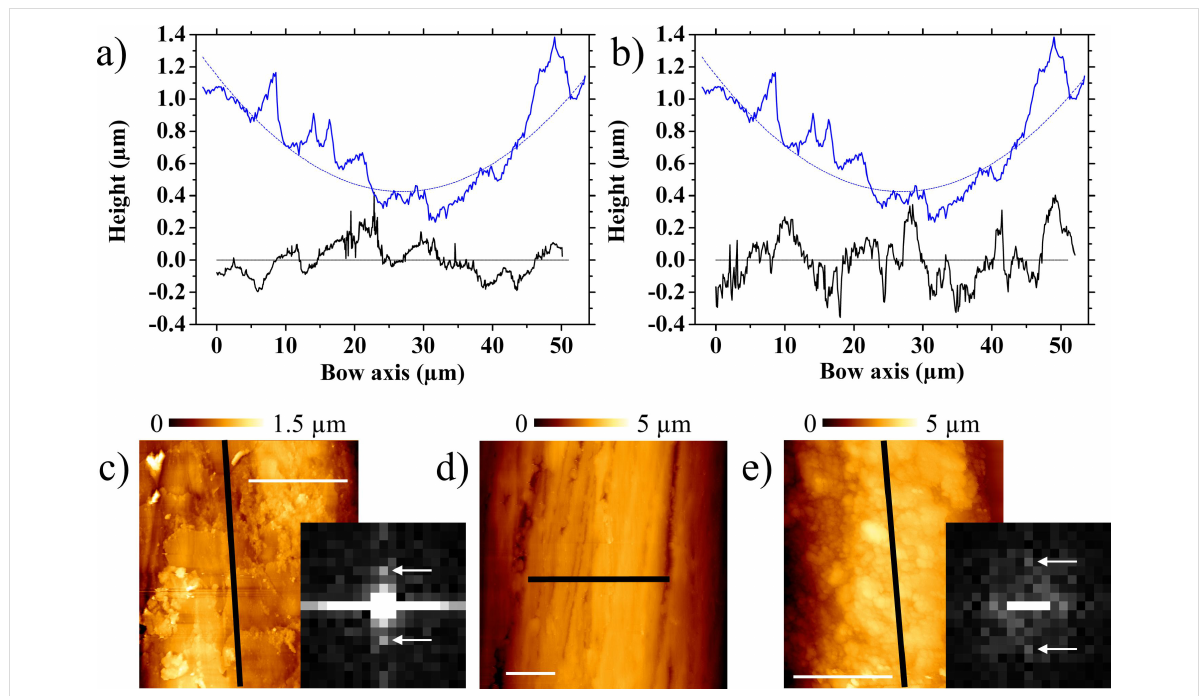
Figure 8: Comparison between the same D-string (upper plots, blue lines) profile shown in Figure 6 and the profiles of sample 1 (a) and 2 (b) surfaces covered by rosin particles. The curved lines correspond to the same section of the cylinder depicted in Figure 6. (c–e) Profile extraction lines for sample 1 (c), the D-string (d), and sample 2 (e). Insets in c and e are the 0.5 × 0.5 µm − 1 central areas of the corresponding two-dimensional fast Fourier transforms at the same intensity contrast. White arrows indicate frequencies associated with 9 µm (c) and 7 µm (e) vertical wavelengths. All white scale bars are 20 µm.